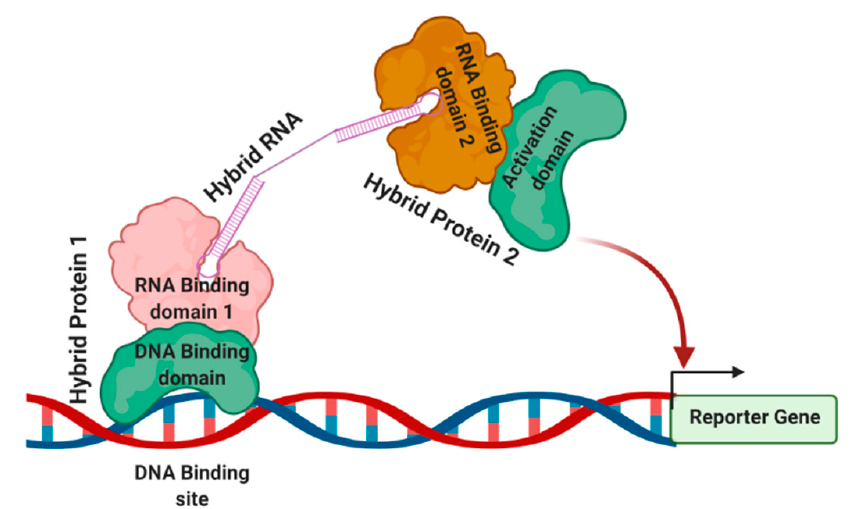
Figure 3. Three-hybrid system to detect and analyze RNA–protein interactions. A three-hybrid system detects RNA–protein interactions. The hybrid RNA interacts with two separate proteins with RNA binding domains that independently interact with proteins containing DNA binding domain and an activation domain, respectively. Once this tripartite complex is formed successfully at the promoter, the reporter gene is activated, serving as a detection method [29,48].